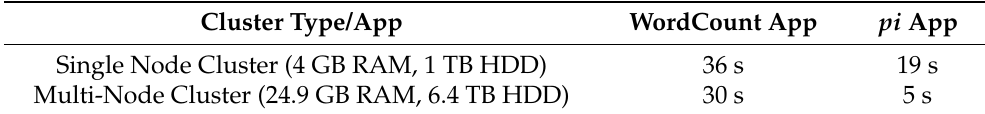
Table 10. Performance Comparison of HPDA Cluster with Single Node